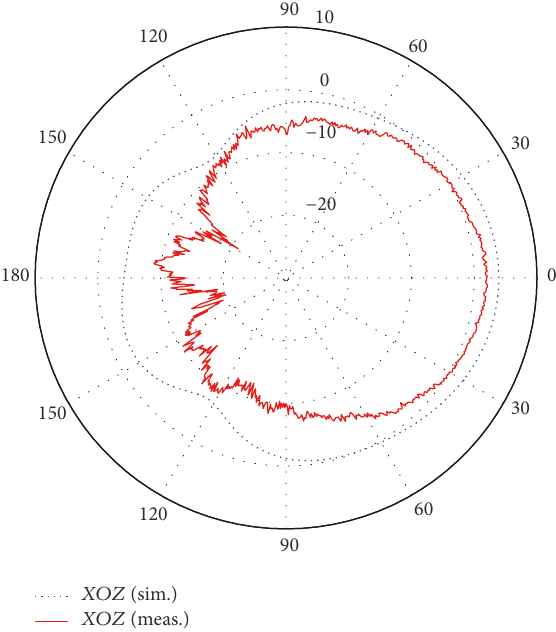
Figure 16: Radiation pattern of the antenna in XOZ plane at 5.8